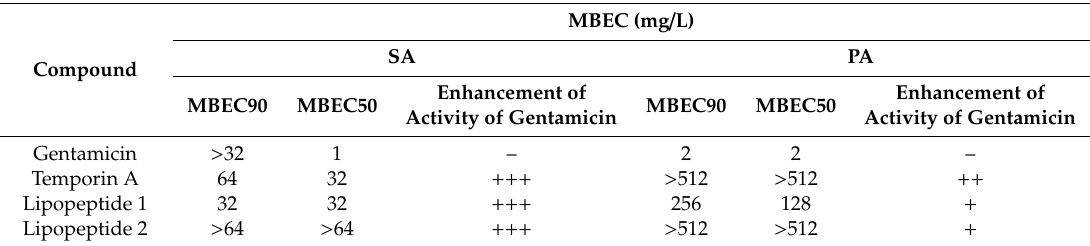
Table 2. Minimum biofilm eradication concentration (MBEC) (mg / L) determined for gentamicin and antimicrobial peptides against SA and PA. MBEC (mg / L) Compound Enhancement of Enhancement of MBEC90 MBEC50 MBEC90 Activity of Gentamicin Activity of